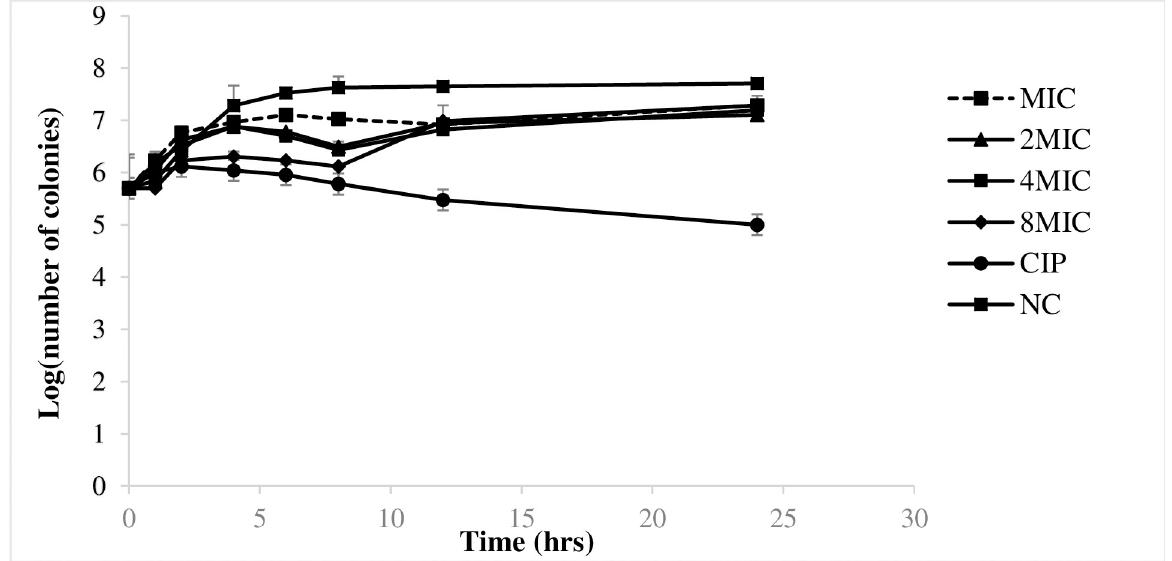
Fig 3. Time-Kill curve of S . typhi following exposure to various concentrations of methanolic roots extract of G . kola . CIP: Ciprofloxacin; NC: negative control; MIC: minimum inhibitory concentration.